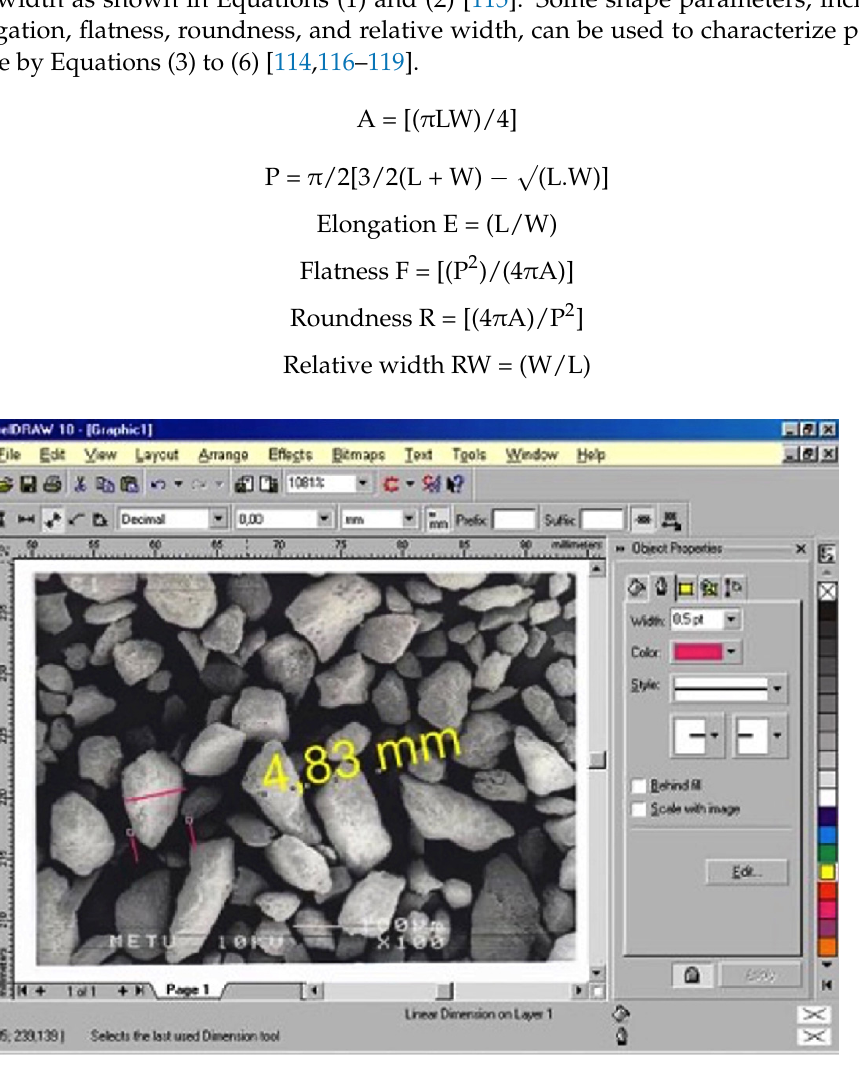
Figure 12. Measurement of axes of particles using software for the characterization of particle shape [113].